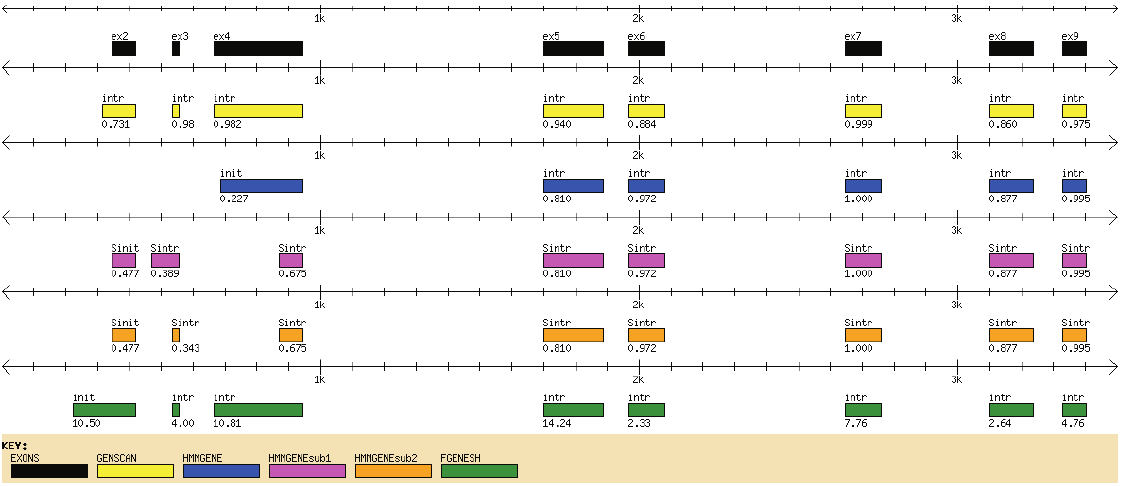
Figure 3: Graphical representation of the optimal/suboptimal, initial ( init ) and internal ( intr ) fea- tures identified within a genomic sequence containing exons 2-9 of the human p53 tumor suppres- sor gene by the three GSDs . The upper track illustrates the actual exonic features ( exX , X :number of exon). The “S” prefix indicates suboptimal